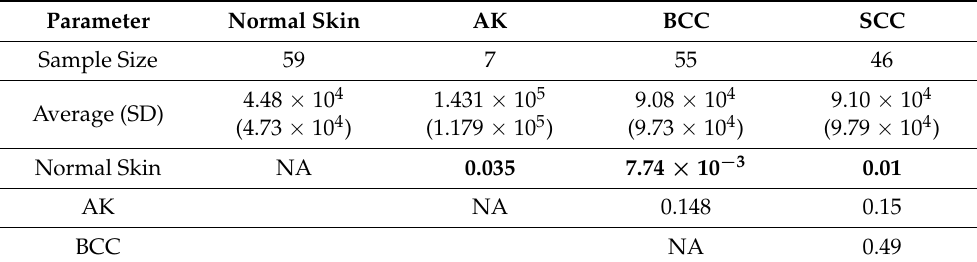
Table 1. Statistical analysis for p -values for VOCT measurement for weighted displacement peak heights in micrometers for audible sound frequency of 80 Hz *.